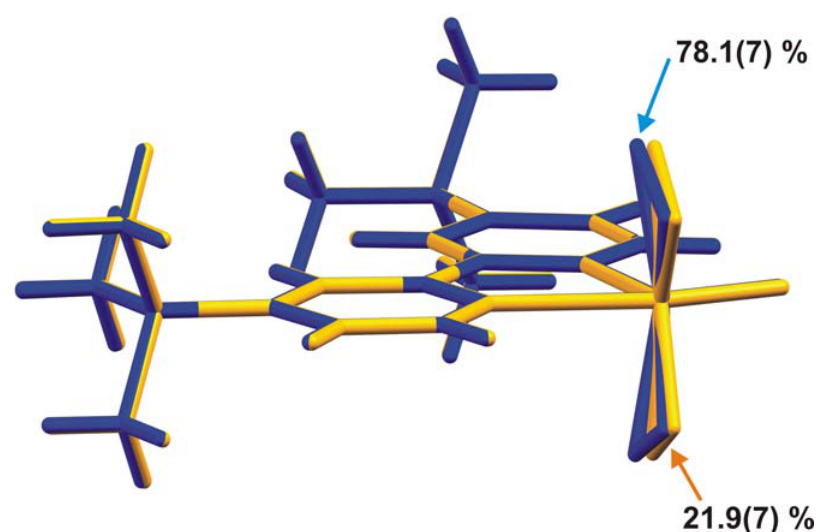
Figure 2. Structure overlay of the two disordered positions for the MoO(O complex present in 1 , emphasising the small geometrical differences for the first coordination sphere of Mo VI .